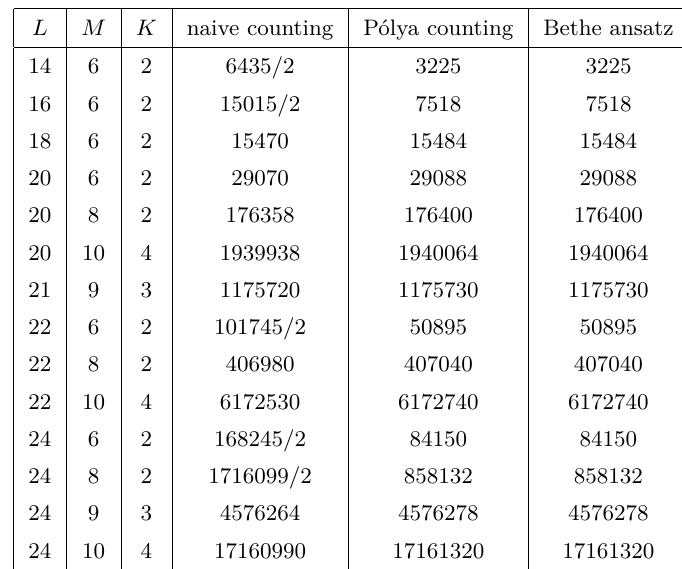
Table 4 . Agreement of the Bethe ansatz solutions of section 3.1.4 with Pólya counting.